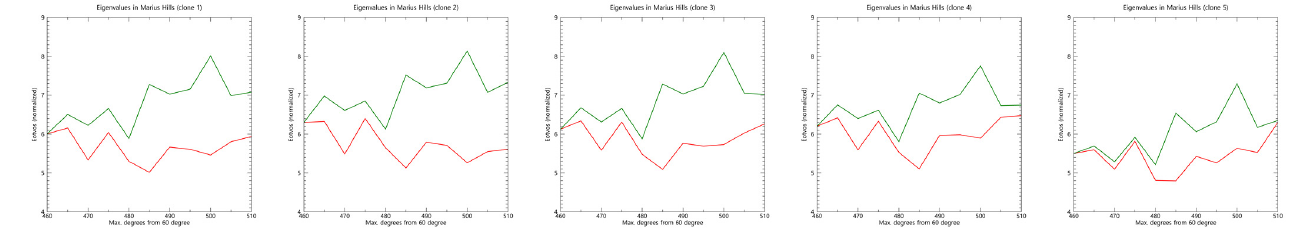
Figure A2. Clone model analysis results for the four regions in Section 3. A total of 5 were randomly selected from among 100 clone models. There are some points where the increasing trend is weak in Stevinus’ clone 3 and clone 5, but it can be seen that a positive trend appears in almost all of the clone models analyzed. Each plot is normalized as shown in Figures 5–7.